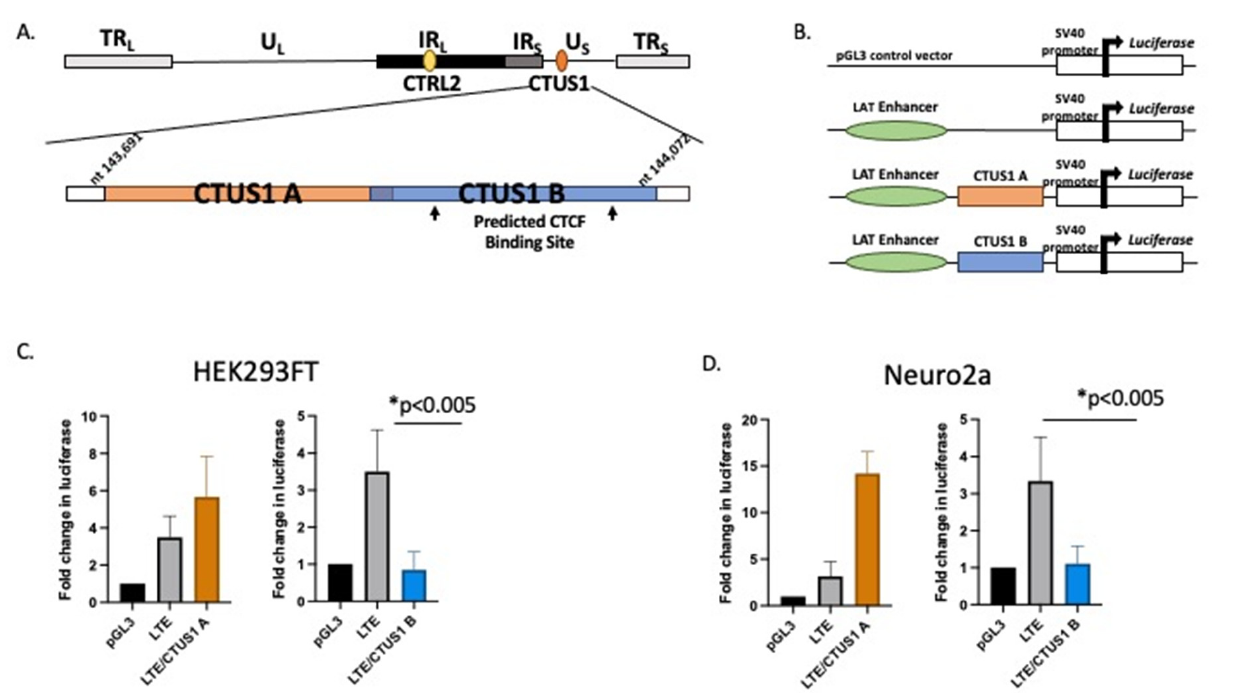
Figure 6. A putative CTCF insulator was identified in the US region of HSV-1 and characterized as an enhancer blocker. Luciferase reporter constructs were generated to test the ability of the CTCF- binding motif to block the LAT enhancer. ( A ) The CTCFBDBS 2.0 program was used to identify the CTUS1B site as a putative CTCF-binding site. The CTUS1A site corresponds to a ~200 bp sequence not predicted to have insulator function (negative control for enhancer-blocking activity). Each CTCF/LTE construct contained ~200 bp of HSV-1 Us region-specific sequences positioned between the LAT enhancer element and the SV40 promoter in thAe pGL3 control vector. ( B ) Reporter con- structs were generated using the commercially available pGL3-control vector (Promega). Constructs contained ~200 bp sequences of the CTUS1A or CTUS1B fragments identified in A, in the presence of the enhancer element in the 5 ′ exon region of LAT (LTE). ( C ) Reporter assays in HEK293FT cells. All transfections were completed in triplicate wells and were repeated 5 times ( n = 3). Data are pre- sented as both a comparison of the LTE to the LTE/CTCF construct and the CTCF compared to the LTE/CTCF construct. * indicates a significant reduction in luciferase expression between the LTE and LTE/CTCF construct; p values <0.001, determined by unpaired one-tailed Student’s t- tests in pairwise comparisons. All luciferase values were normalized to the pGL3 control, which was set to 1. ( D ) Reporter assays were performed in neuro 2a cells. All transfections were completed in tripli- cate wells and were repeated 5 times ( n = 3). Data are presented as both a comparison of the LTE to the LTE/CTCF construct and the CTCF compared to the LTE/CTCF construct; * indicates a signifi- cant reduction in luciferase expression between the LTE and the LTE/CTCF construct where p < 0.001, determined by unpaired one-tailed Student’s t- tests in pairwise comparisons. 4. Discussion CTCF insulators are important regulatory domains that have extensive roles in the transcriptional control of eukaryotic gene expression. The role of chromatin insulators in the context of DNA viruses has become an intense area of focus recently; investigators have shown that these insulators establish chromatin barriers, recruit co-activating or co- repressing protein complexes, and can self-dimerize to form chromatin loops that regulate transcription over large genomic spans [3,39–43]. To this end, we have previously shown that there are multiple putative CTCF insulators in the HSV-1 genome, that the protein CTCF is differentially bound to these sites, and that many have enhancer-blocking func- tion, suggesting that they are functional insulators that are involved in the transcriptional